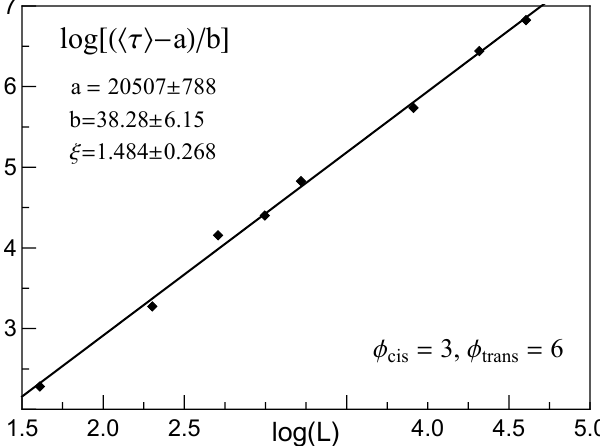
Figure 4. Illustration of the power law relation given by Equation